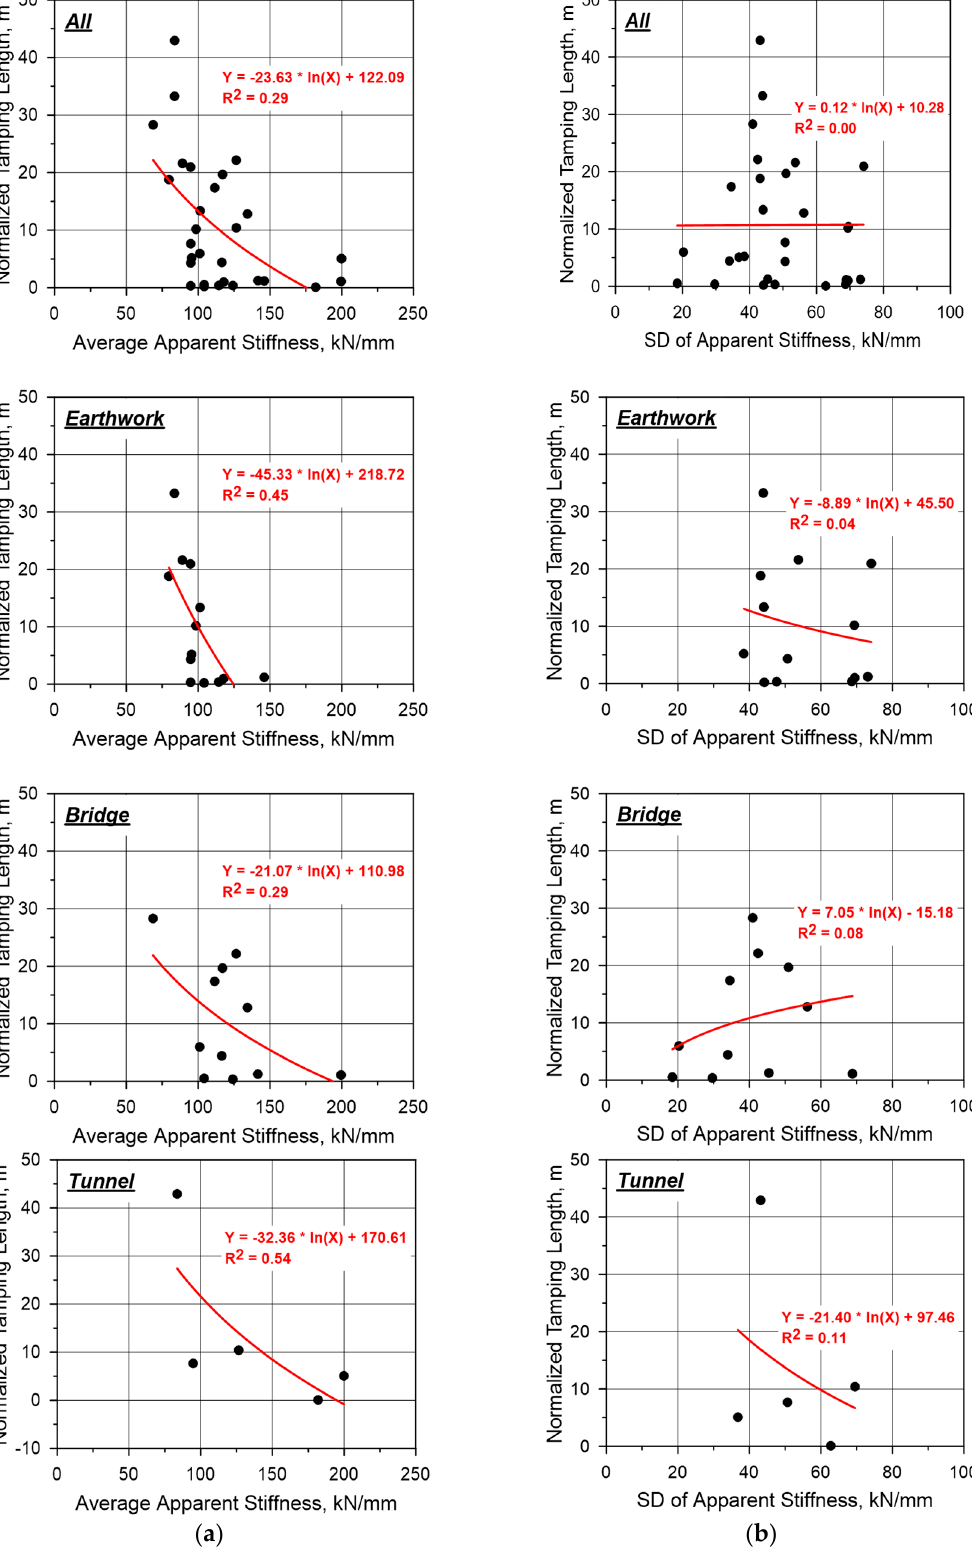
Figure 6. Apparent stiffness versus normalized tamping length: ( a ) Average vs. tamping length; ( b ) Standard deviation vs. tamping length.